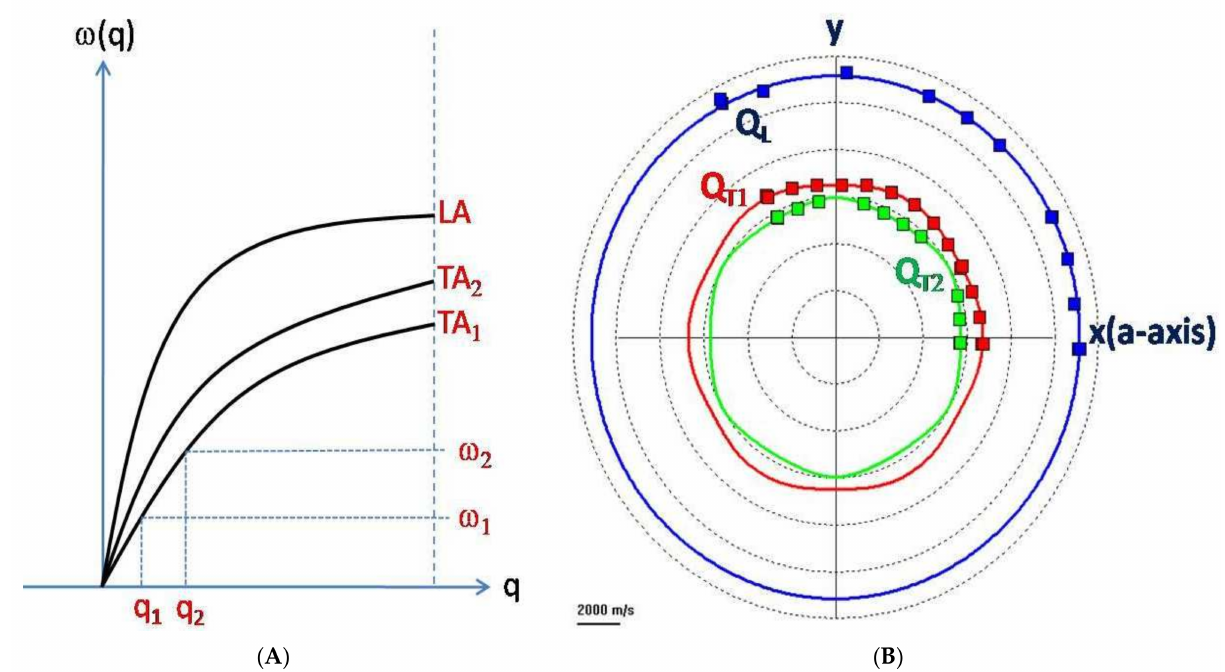
Figure 4. ( A ). Principle of dispersion curves for acoustic phonons of a crystalline material. There are three branches of acoustic phonons: one longitudinal (LA) branch and two transverse (TA 1 and TA 2 ) branches. A change in the acoustic wave vector ( q ) implies a change in the Brillouin frequency shift ( ω ). This indicates that the geometry of acquisition must be carefully assessed as different acoustic modes can fall on the same frequency shift for different geometries. ( B ). Orientation dependence of the sound velocity of sapphire in the (0001) plane (own data). Q L is the quasilongitudinal acoustic branch, while Q T 1 and Q T 2 are the two quasitransverse acoustic branches. x and y represent the main crystallographic directions. Q T 1 and Q T 2 are present because sapphire is an anisotropic crystal and as such, it has lateral and top-down transversal polarizations. These modes depend on the orientation of the crystal. In this case, each angular point of the color curves of the diagram represent Brillouin measurements acquired for different rotations of the x–y plane around the z axis (perpendicular to the plane). Preferential directions along which sound waves can propagate more easily appear as larger shifts of the transverse